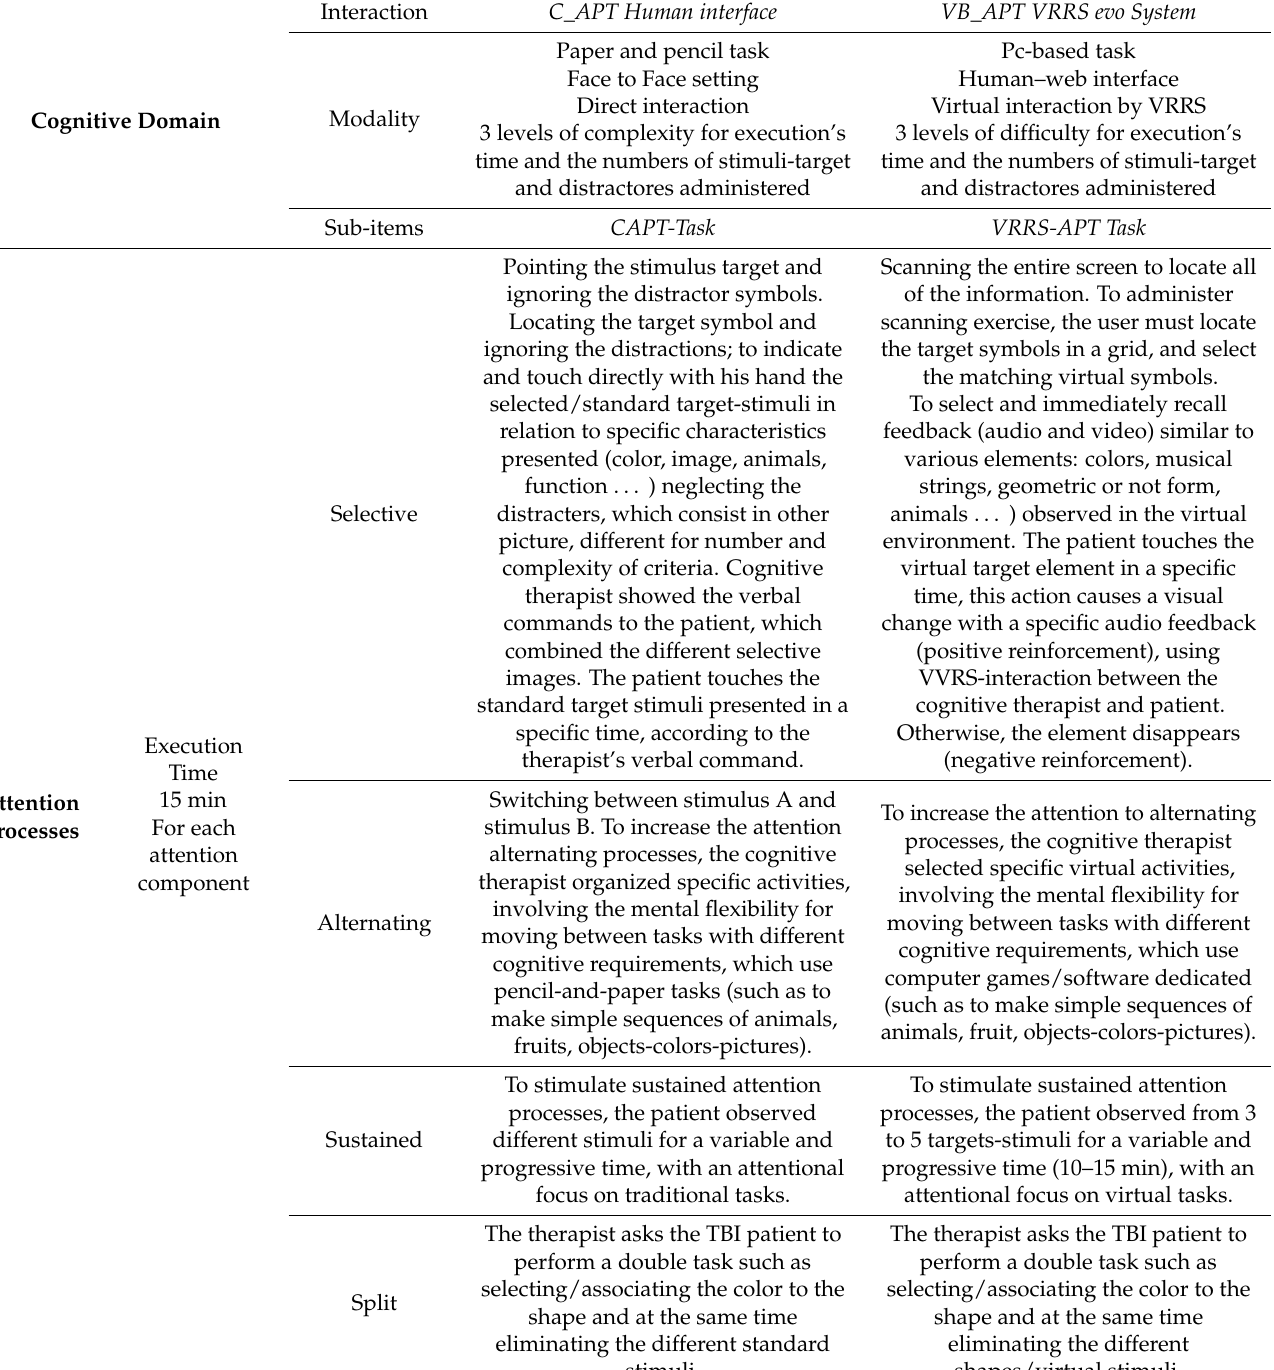
Table 3. TBI-Attention Processes training, including both conventional and innovative